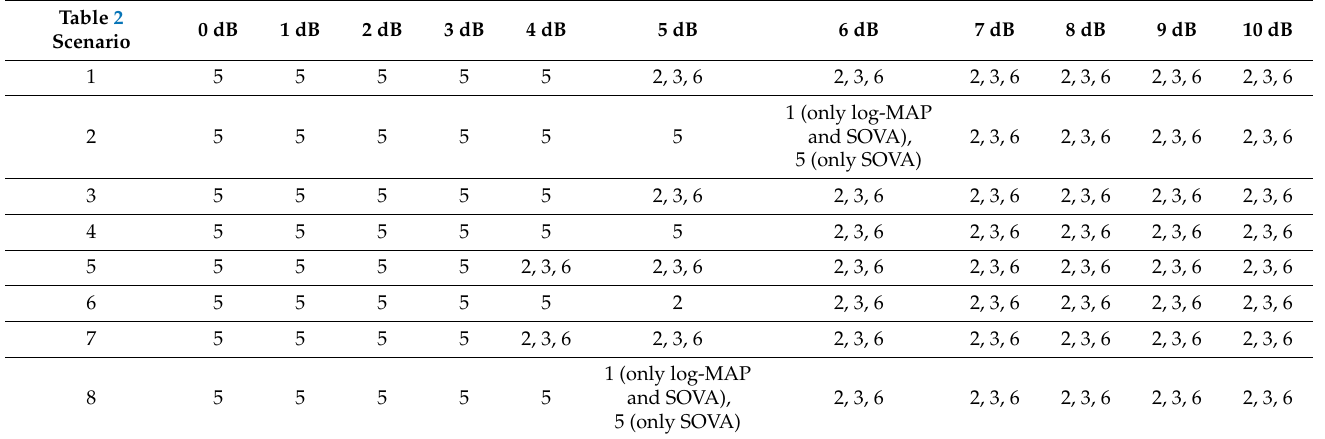
link reliability